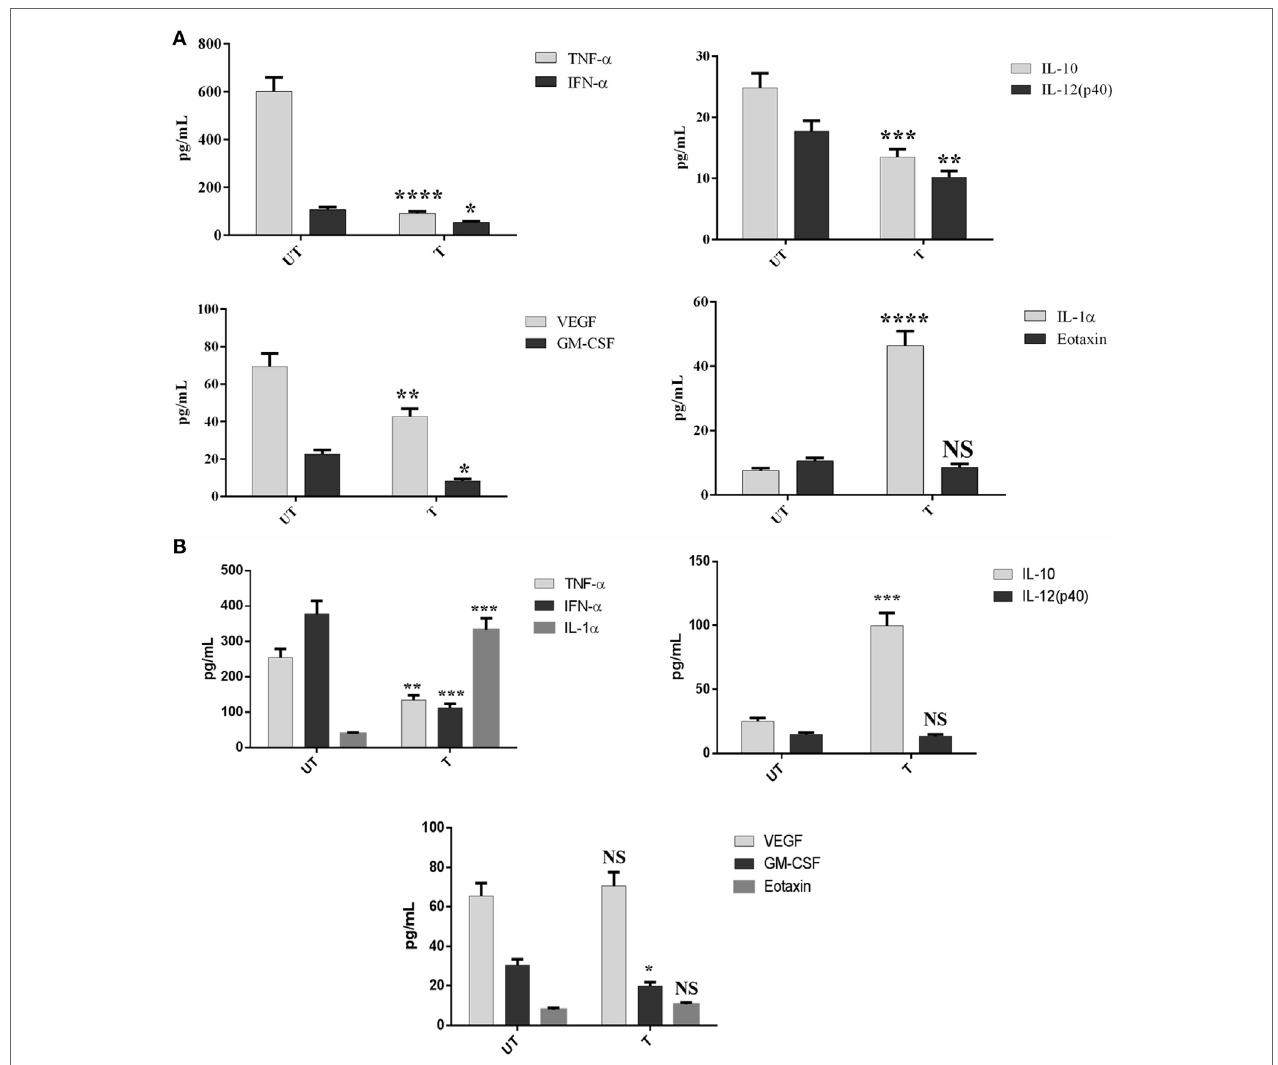
FigUre 7 | Multiplex cytokine array analysis of supernatants that were collected at 24 h time point. A549 cells were infected with pH1N1 (a) and H3N2 (B) , treated with 10 µg/ml of rfhSP-D. Cytokines (TNF- α , IL-6, IL-10, IL-1 α , IFN- α , and IL-12p40), chemokine (eotaxin), and growth factors (GM-CSF and VEGF) were measured using a commercially available MagPix Milliplex kit (EMD Millipore). Assays were conducted in triplicates and error bars represent ± SEM ( n = 3); significance was determined using unpaired one-way ANOVA test (* p < 0.05, ** p < 0.01, *** p < 0.001 and **** p <